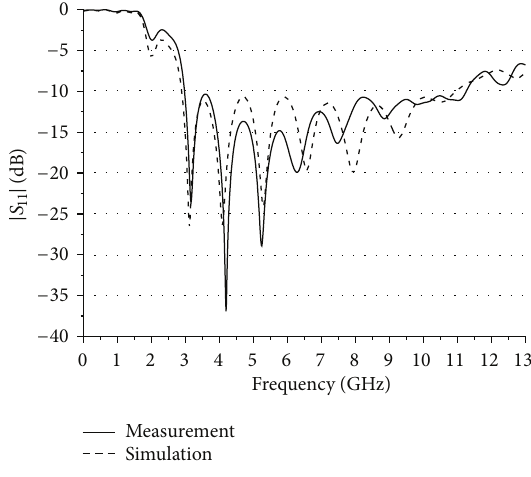
Figure 9: |𝑆 11 | of improved